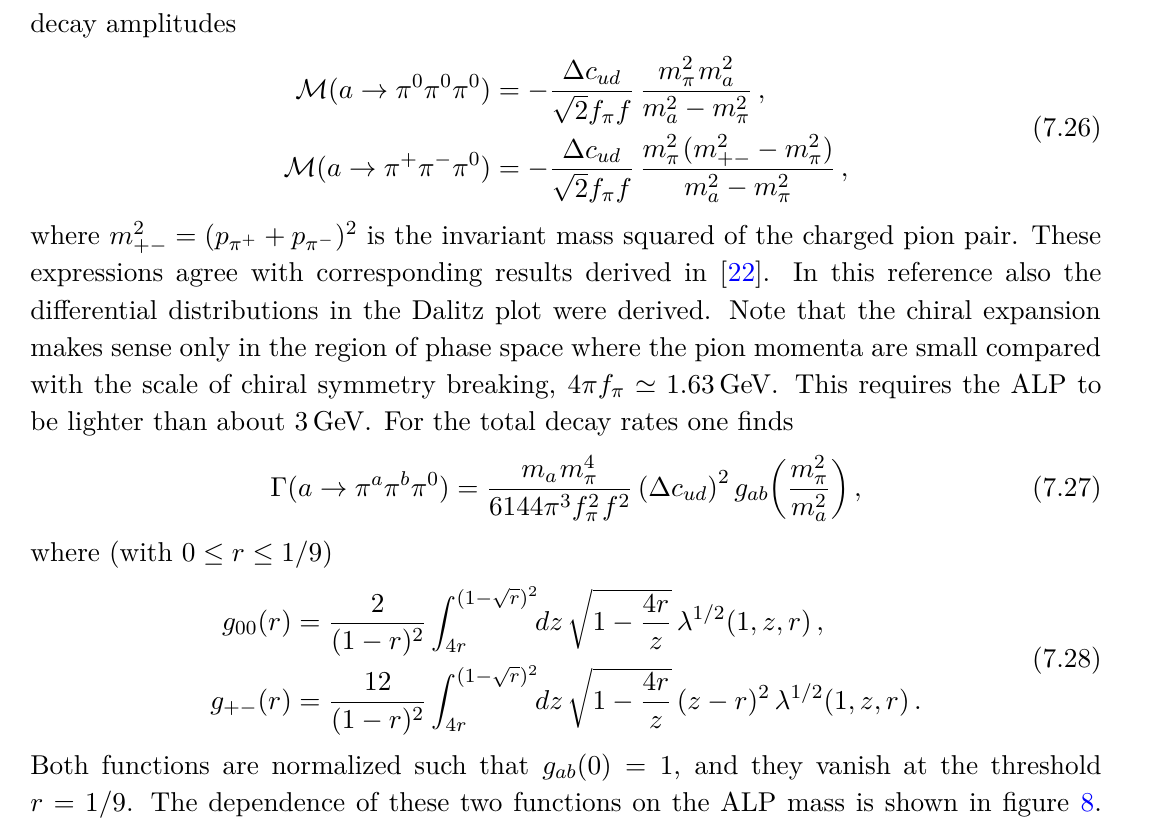
Figure 8 . Dependence of the phase-space functions g 00 ( r ) (blue) and g + − ( r ) (red) on the ALP mass (with r = m 2 /m 2 π a